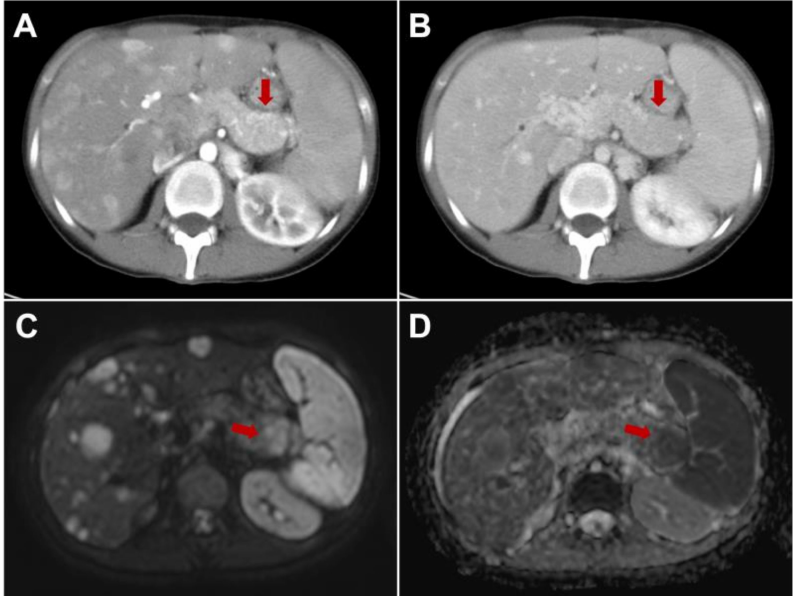
Figure 4. A 35-year-old female with atypical metastatic pancreatic neuroendocrine neoplasm of the tail, difficult to identify in contrast-enhanced CT due to the iso-enhancement in arterial (( A ), arrow) and portal (( B ), arrow) phase. It was detected by MRI by using diffusion-weighted images, showing hyperintensity on the DWI (( C ), arrow) and low signal intensity on the ADC map (( D ),